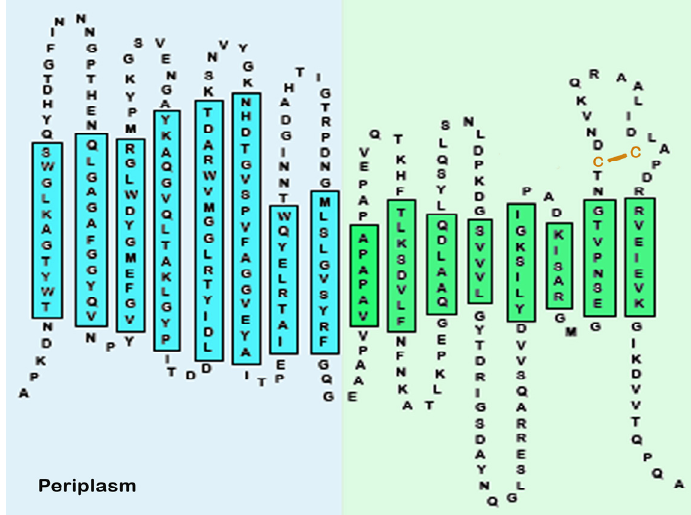
Figure 8. Composite topological structure of OmpA. Left (blue): topological of the N -terminal domain of OmpA (residues 1–175), as determined by X-ray crystallography performed by Pautsch & Schultz [76,77]. Right (green): hypothetical topology of the C -terminal domain (residues 175–325), as proposed by Stathopoulos [88]. From Reusch 2012